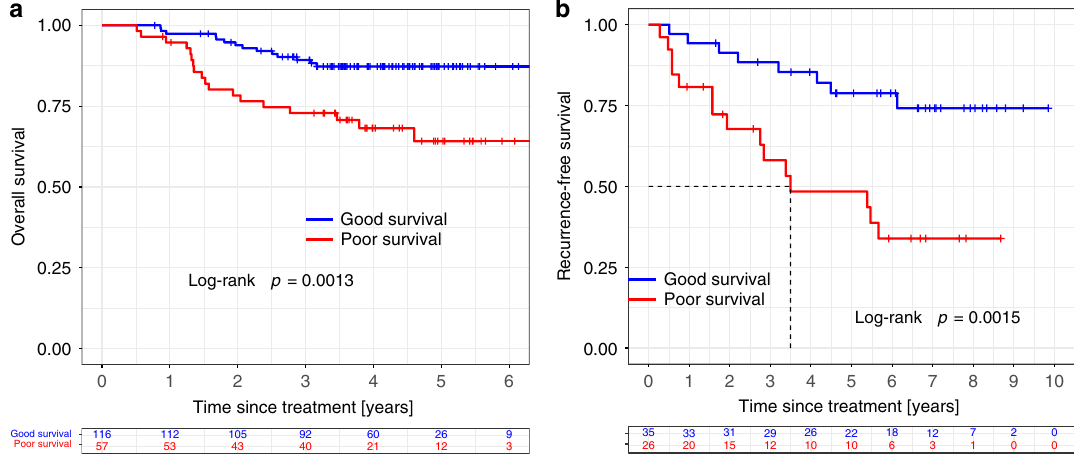
Fig. 7 Radiogenomic signatures validated as predictors of breast cancer prognosis. a , b Kaplan – Meier curves of survival in the prognostic assessment ( p = 0.0013, two-sided log-rank test) and prognostic testing ( p = 0.0015, two-sided log-rank test) datasets for overall survival and recurrence free survival, respectively. Red and blue plots represent poor survival and good survival groups,